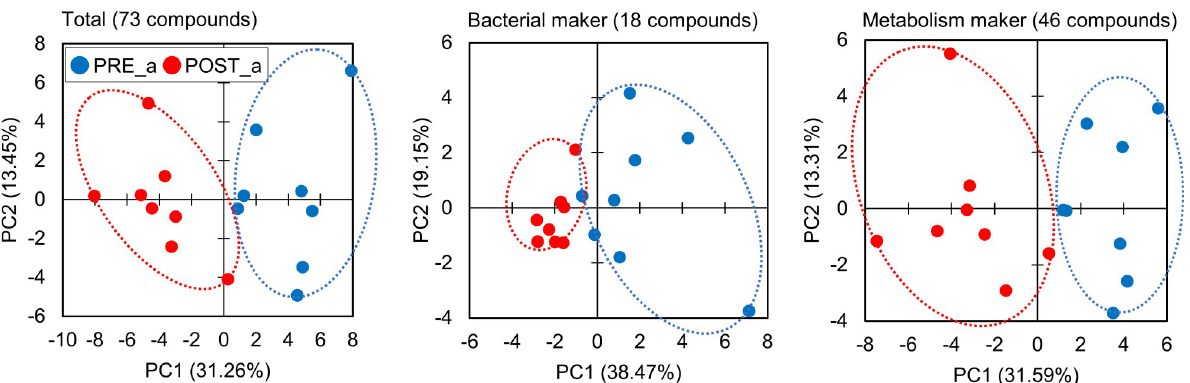
Fig 3. Principal component analysis (PCA) score plots. (Left panel) Total: 73 compounds. (Center panel) Bacterial marker: 18 compounds. (Right panel) Metabolism marker: 46 compounds. PRE_a: before LEX-ingestion (blue closed circle), POST_a: after LEX ingestion (red closed circle).